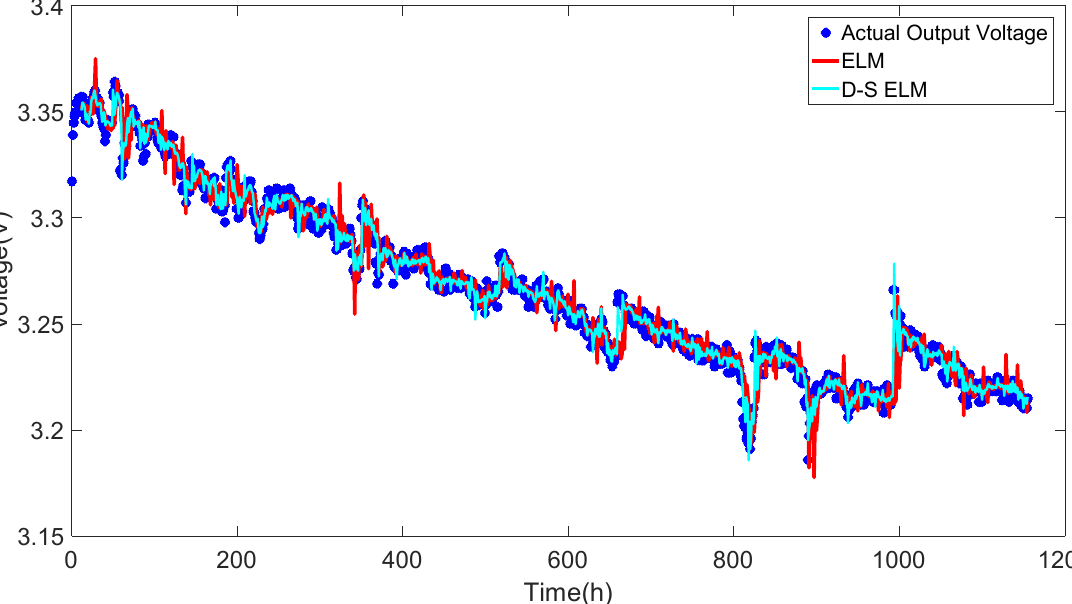
Figure 6. Prediction results of extreme learning machine (ELM) and D-S ELM (the size of training sample is set as 10).